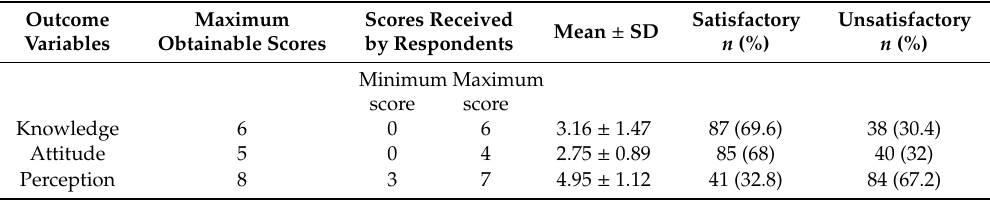
Table 2. Description of scores obtained by respondents for knowledge, attitude, and perception towards antibiotic resistance (ABR) ( n =